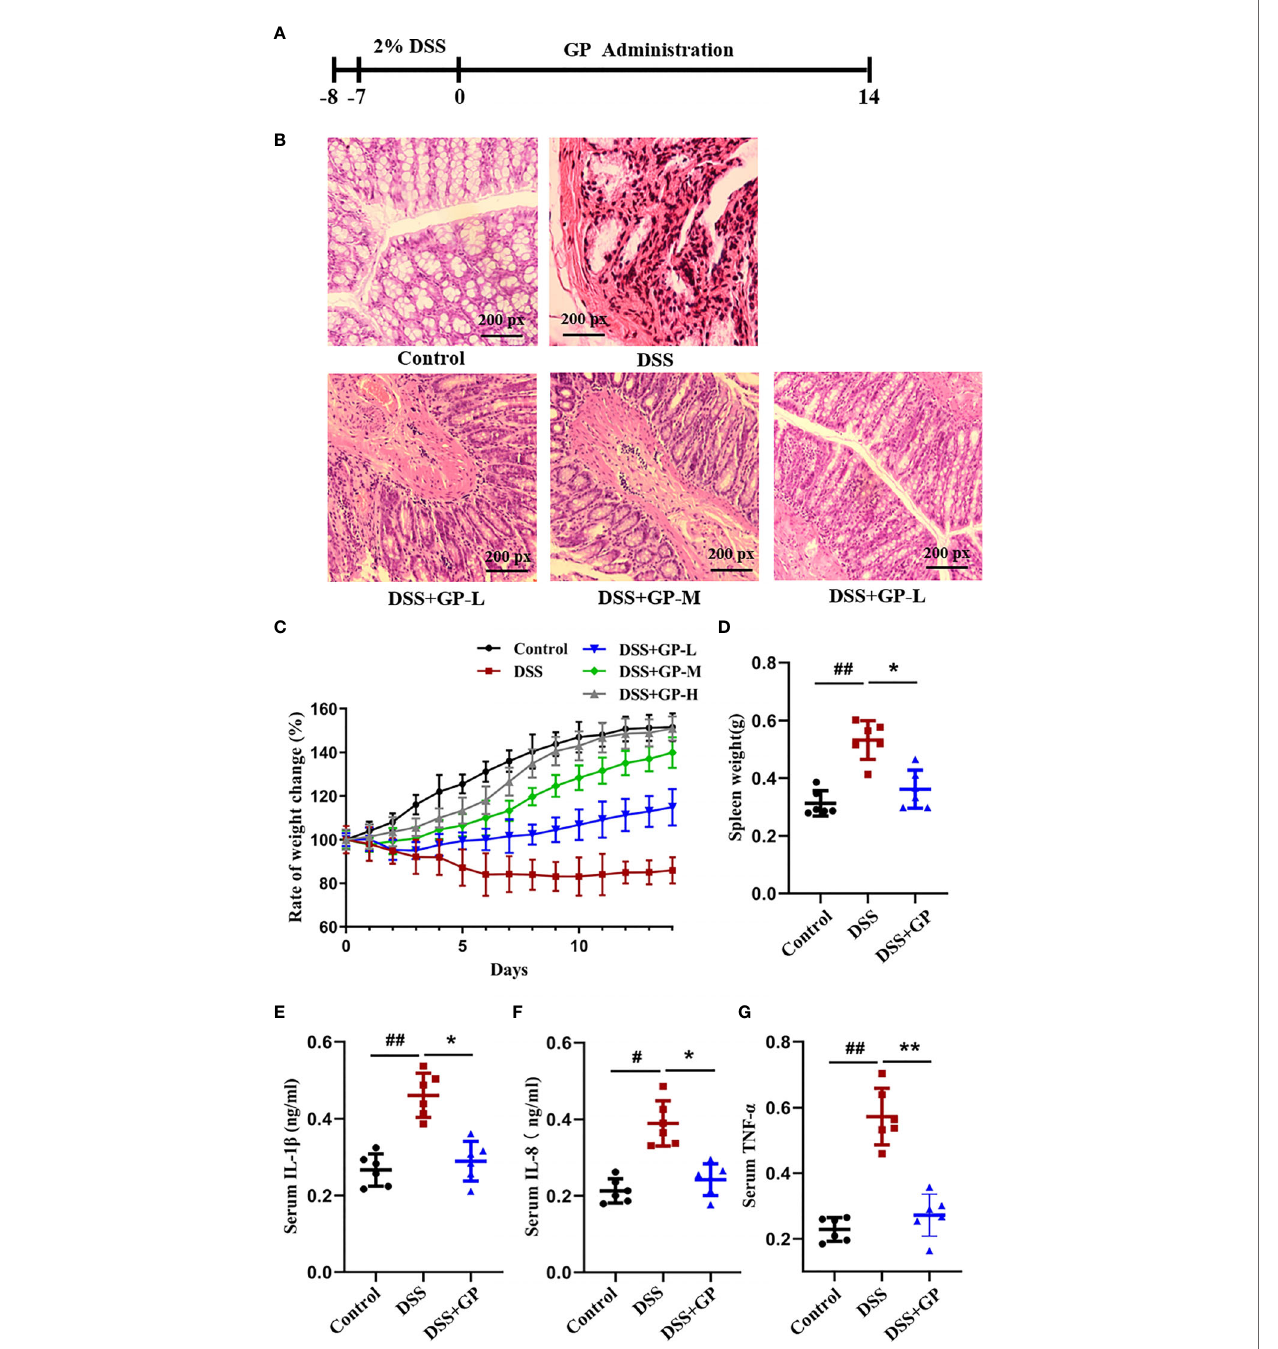
FIGURE 2 | GP alleviated the intestinal in fl ammation in rats with DSS induced colitis. (A) Experimental operation process. (B) H&E stained sections of the differently treated rats as described above. (C, D) The effects of GP on Rats ’ basal body weight and Spleen weight. (E – G) Changes of cytokines in different groups in vivo. All data shown are representative of 3 independent experiments. Bars in graphs represent mean ± SD, # P < 0.05, ## P < 0.01 VS Control group; *P < 0.05, **P < 0.01 VS DSS